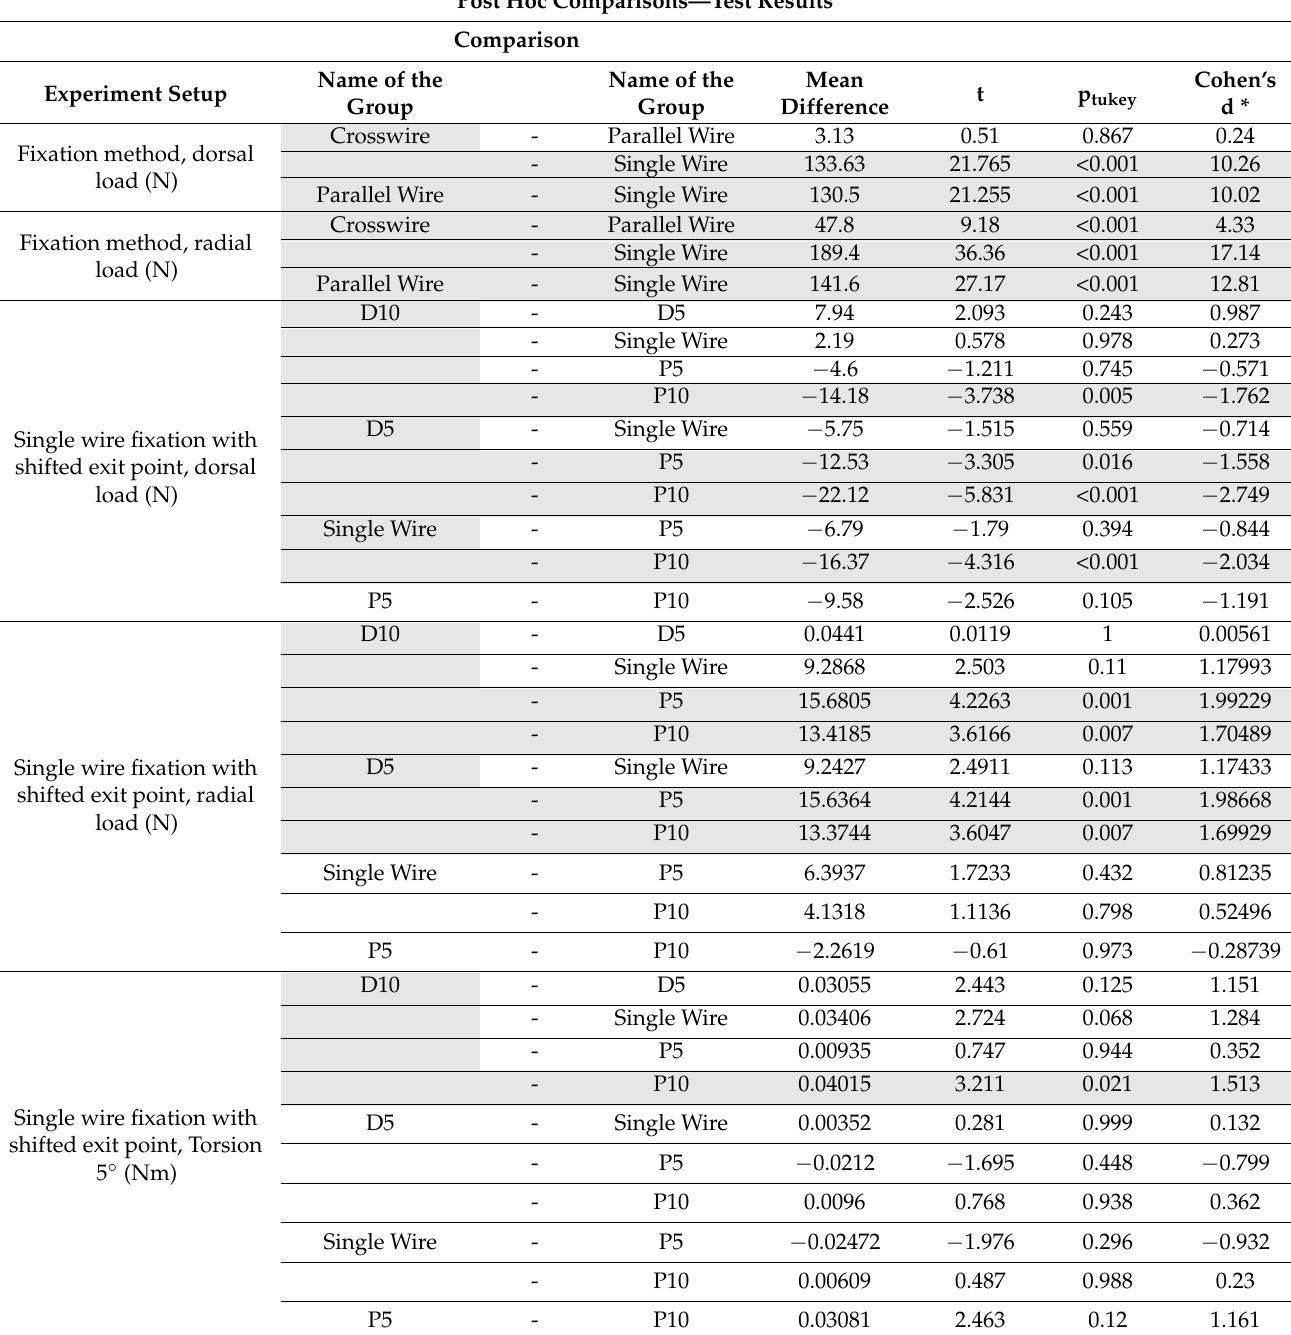
Table A4. Results of the post hoc (Tukey) tests. The level of significance was set to 5% ( α = 0.05). Statistically significant (ptukey < 0.05) results are highlighted with light